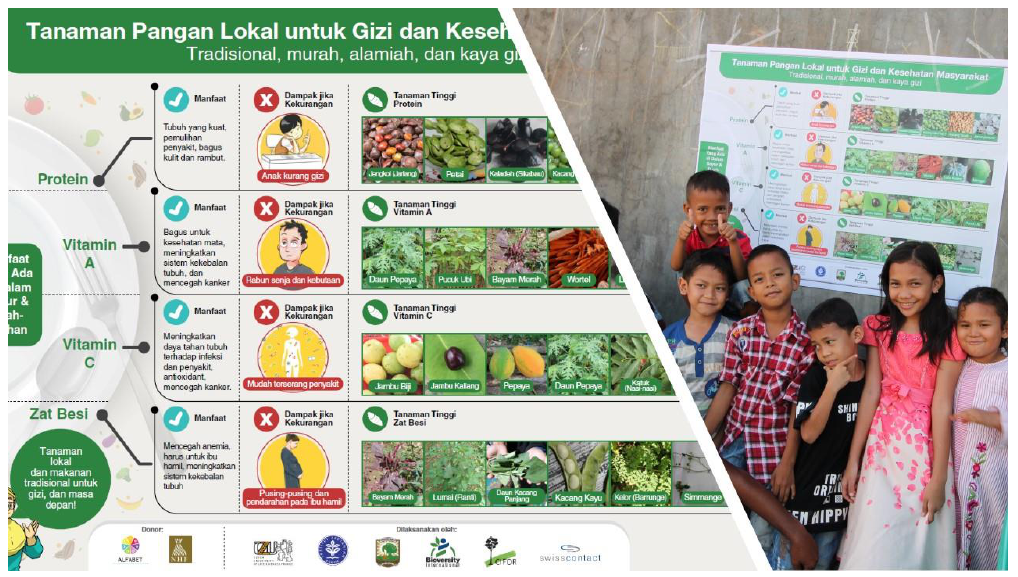
Figure 8. Community poster in local language developed in West Sumatra, Indonesia, as part of the “Food, Agrobiodiversity, and Diet project” explaining the health benefits of local food plants that are rich in protein, vitamin A, vitamin C, and iron, and Mandailing children learning about local foods. Credit: Lukas Pawera.